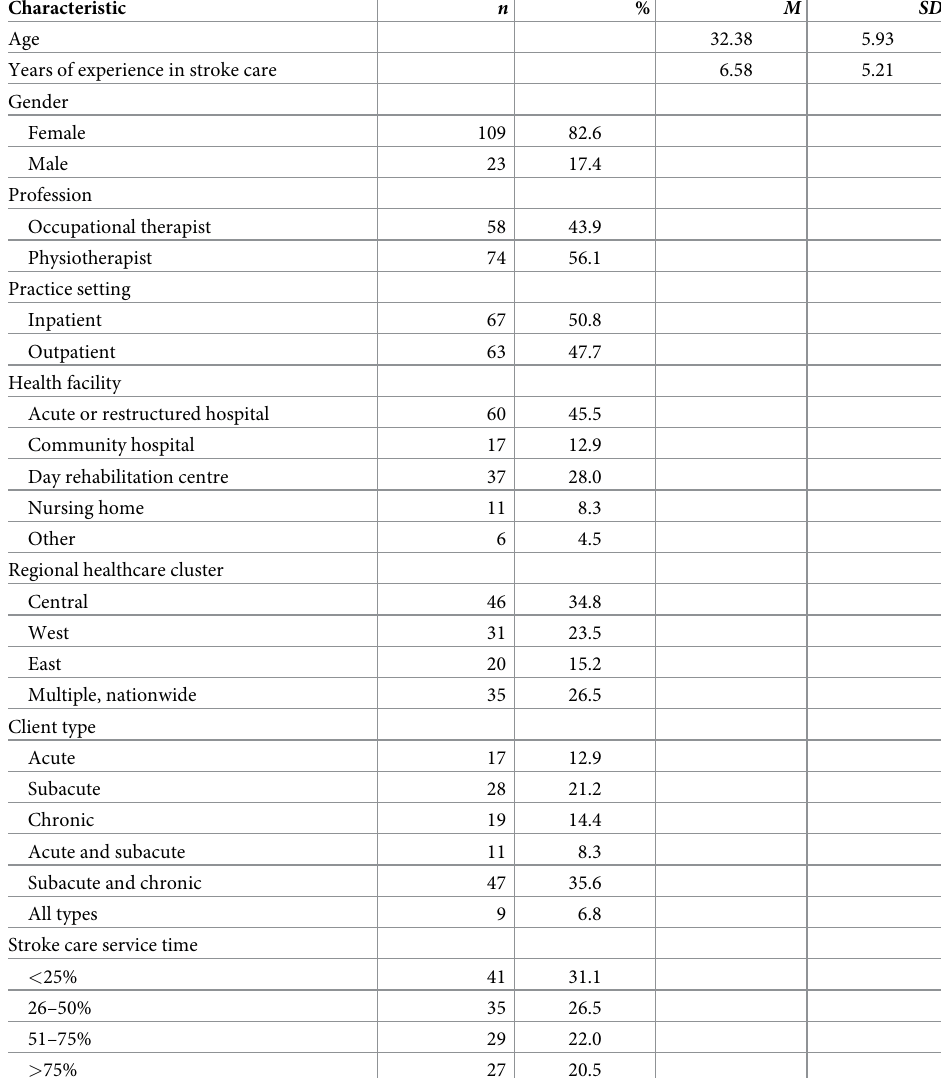
Table 1. Participants demographic